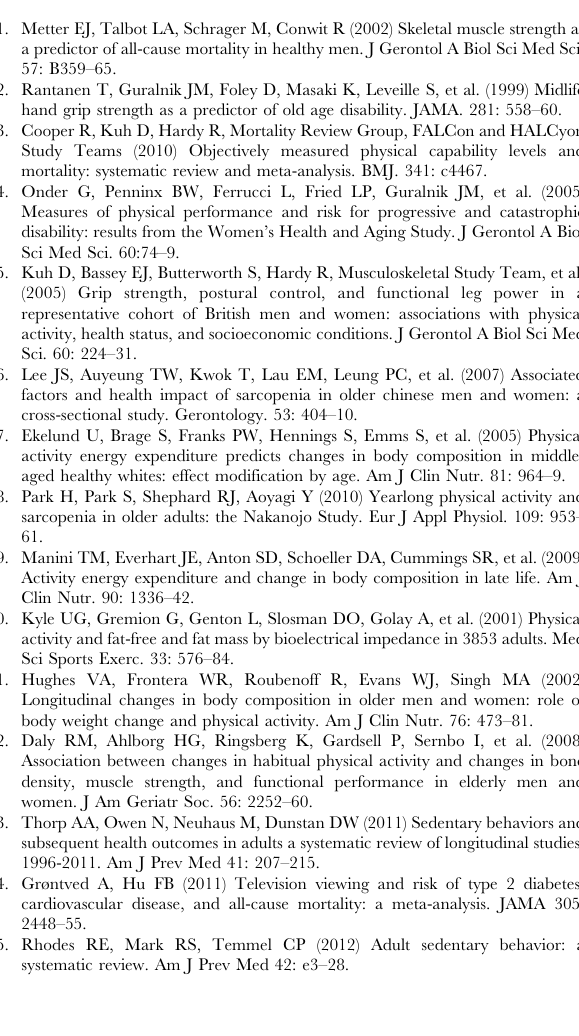
Table S2 The association between covariables and muscle strength in women (N